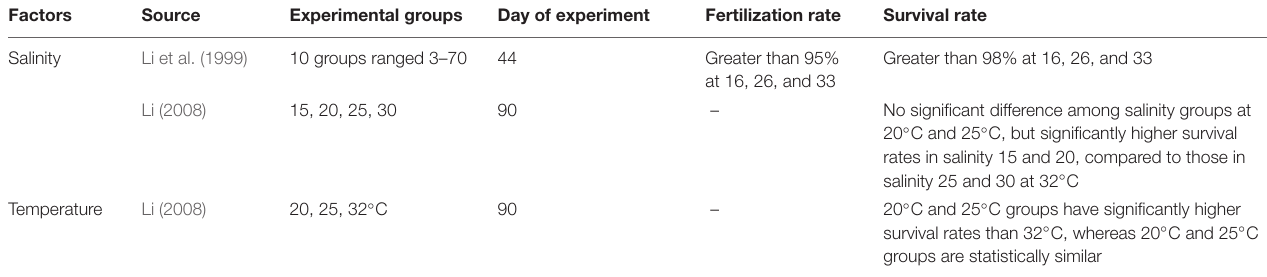
TABLE 1 | Effects of various environmental factors on fertilization and survival of T. tridentatus embryos in hatcheries (–, no